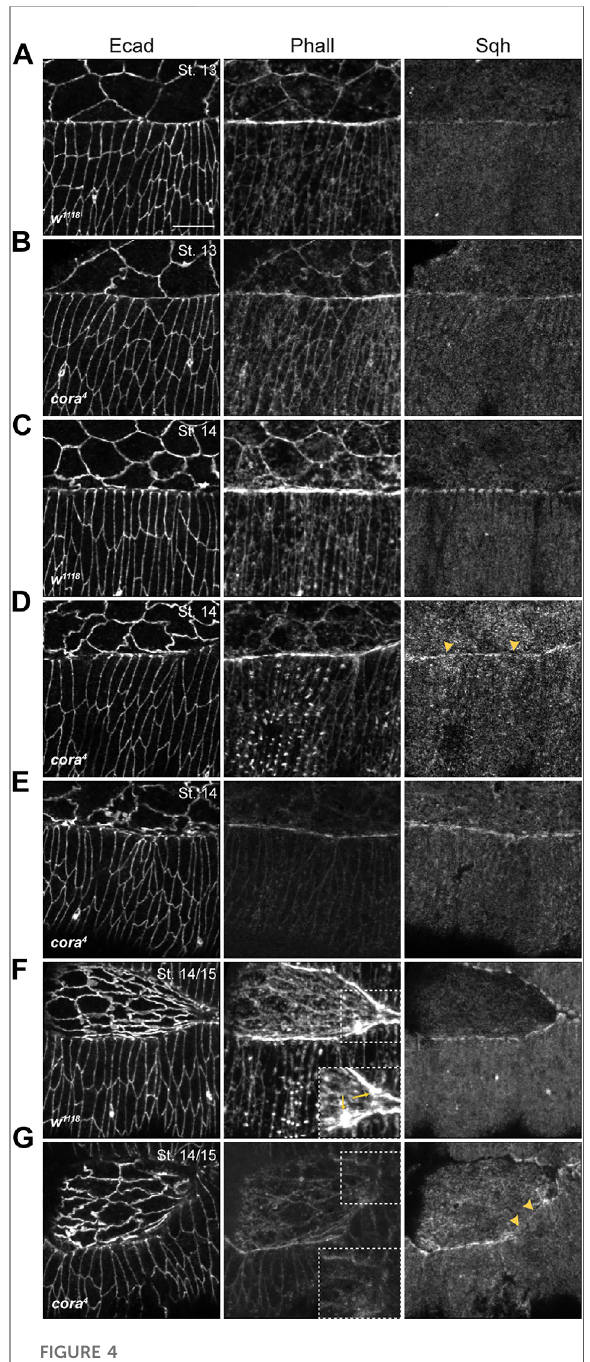
FIGURE 4 SJ mutant embryos have defects in actomyosin cable formation during late stages in DC. (A – G) Confocal optical sections of stage 13, stage 14, and stage14-15 wild type and cora 4 embryos stained with antibodies against Ecad, Sqh and Alexa Fluor 555 Phalloidin (Phall). (A) Stage 13 wild type embryos have continuousenrichmentofF-actinandmildaccumulationofSqhat the leading edge. (B) cora 4 embryos exhibit a similar expression of Sqh and F-actin at the leading edge, with mild reduction in F-actin enrichment. (C) The leading edge of stage 14 wild type embryos have strong enrichment of F-actin, along with a “ bars-on-string ” distributionofSqh. (D) Stage 14 cora 4 embryos haveareductionof ( Continued )